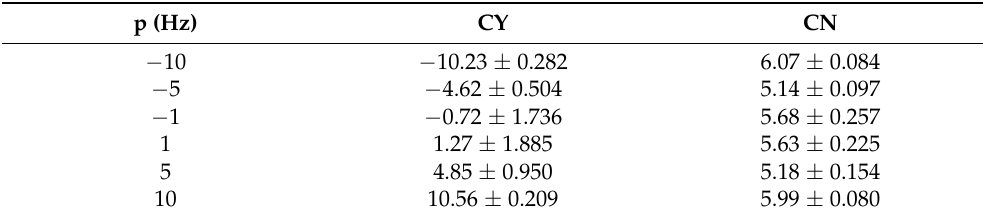
Table 4. Averaged side and normal force coefficients versus spin velocity at Ma = 0.2, Re = 2 × 10 6 and α = 35 degrees.